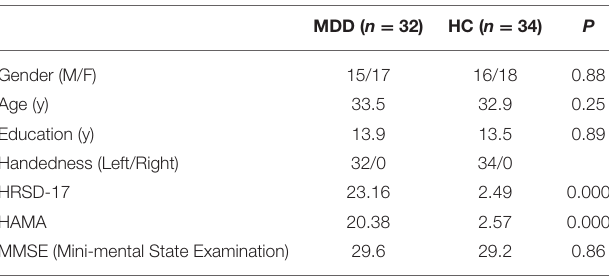
TABLE 1 | Demographic and clinical characteristics of major depressive disorder (MDD) and healthy controls